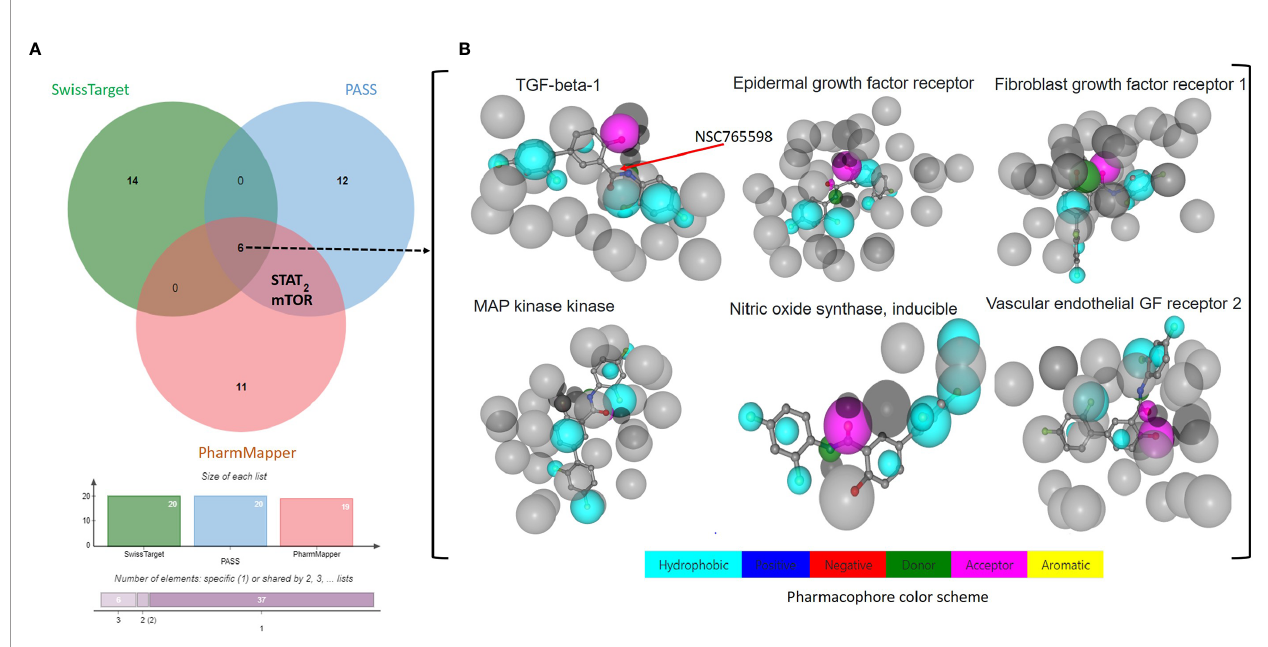
FIGURE 2 | Potential targets for NSC765598. (A) Venn diagram showing common targets of NSC765598 as revealed by the SwissTarget, PASS, and PharmMapper algorithms. Six genes including iNOS, TGFB1, vascular endothelial growth factor receptor 2, FGFR, EDFR, and MAPK2 were predicted by the three algorithms ( Figures 3A, B ), while two genes, viz., signal transducer and activator of transcription and serine/threonine-protein kinase mTOR, were predicted to be top ranked targets of NSC765598 by the two algorithms. (B) Pharmacophore-based models of the six commonly identi fi ed NSC765598 target predictions via protein-receptor